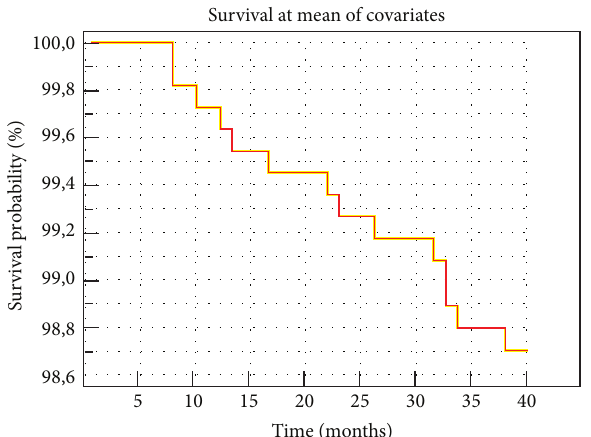
Figure 4: Kaplan-Meier estimates of cardiovascular survival in general